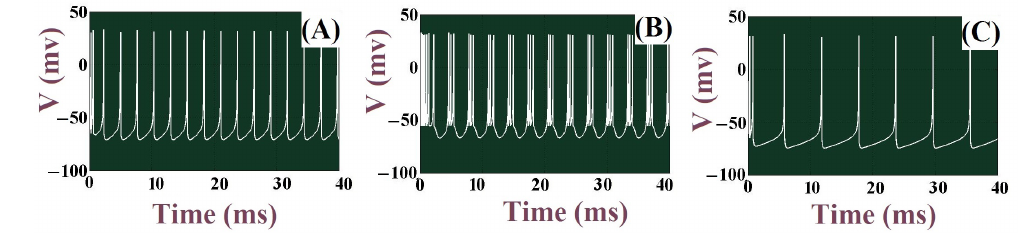
Figure 12. Digital oscilloscope signals for proposed neuron inplementation. ( A ) Tonic spiking pattern. ( B ) Tonic bursting pattern. ( C ) Spike frequency adaption